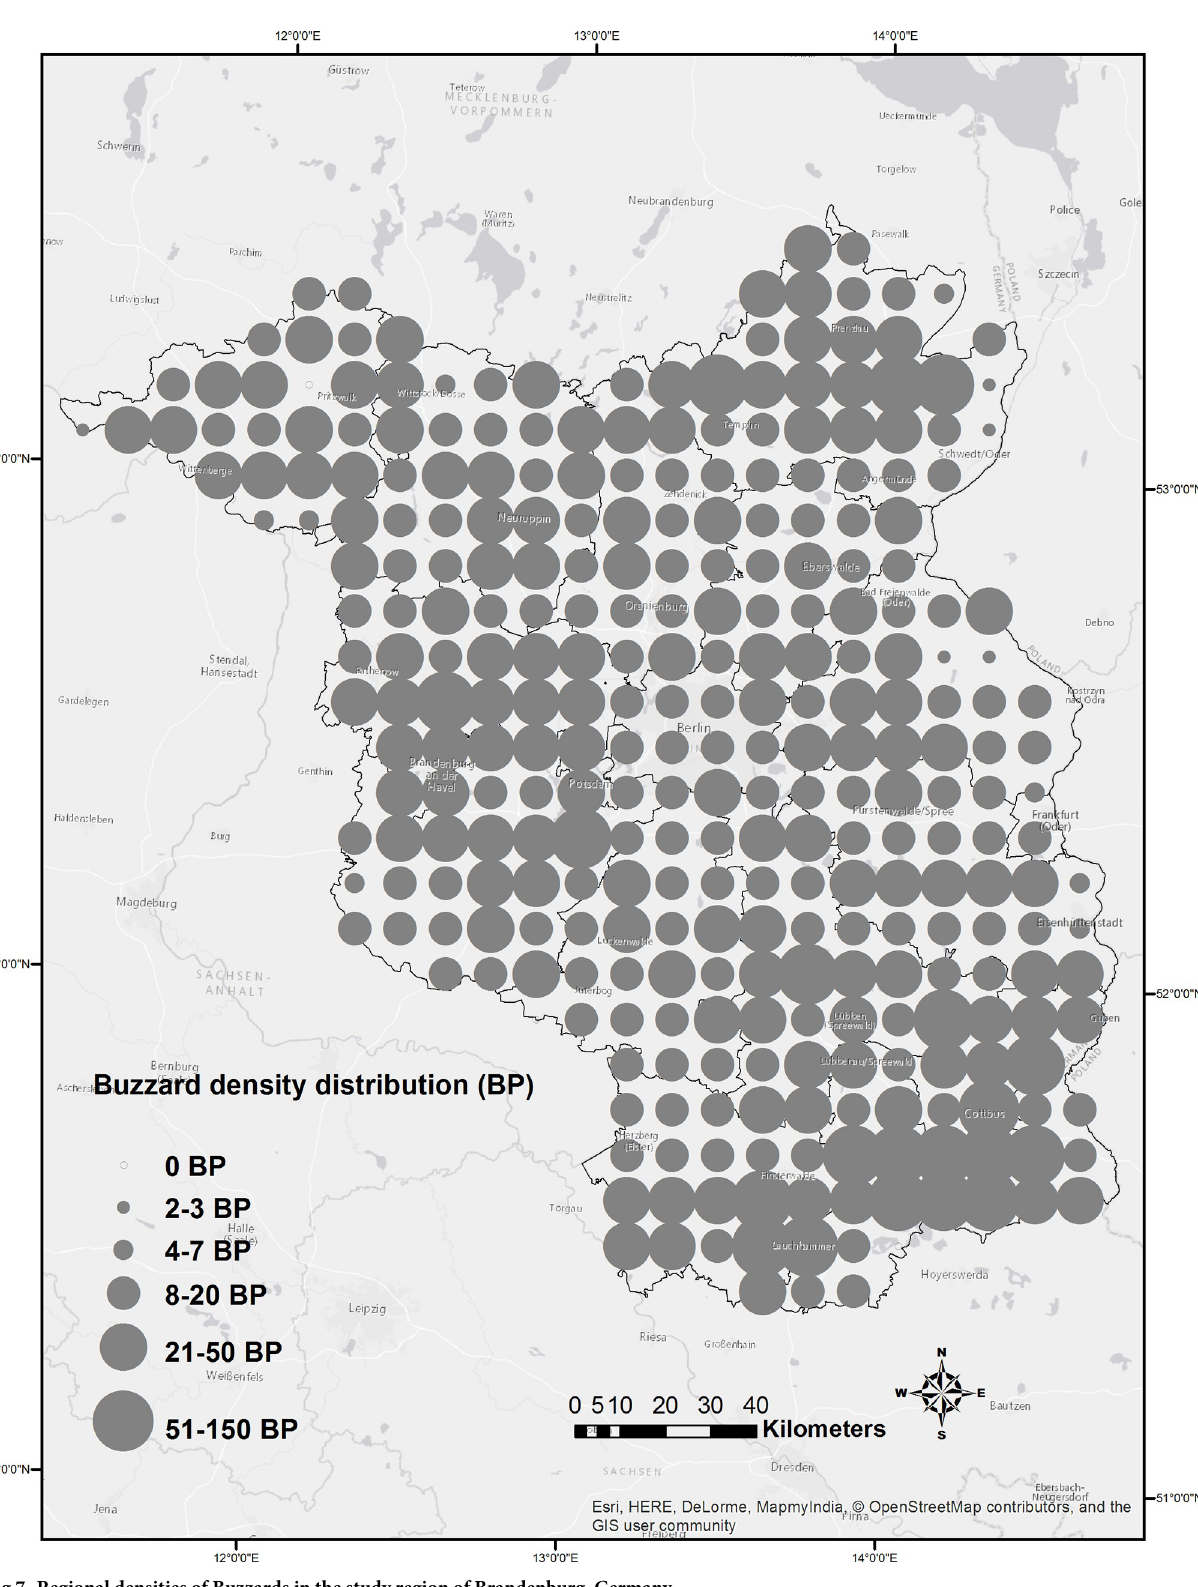
Fig 7. Regional densities of Buzzards in the study region of Brandenburg, Germany.